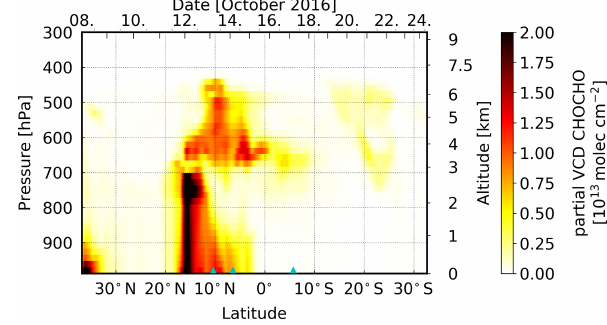
Figure 13. HCHO MOZART-4 profiles as used for VCDs calcu- lations, interpolated on the cruise track (from north to south). The blue triangles on the bottom indicate the position of RV Maria S. Merian on the days with unusual scan angle dependency. For the calculation of the altitude, a mean temperature profile is used.